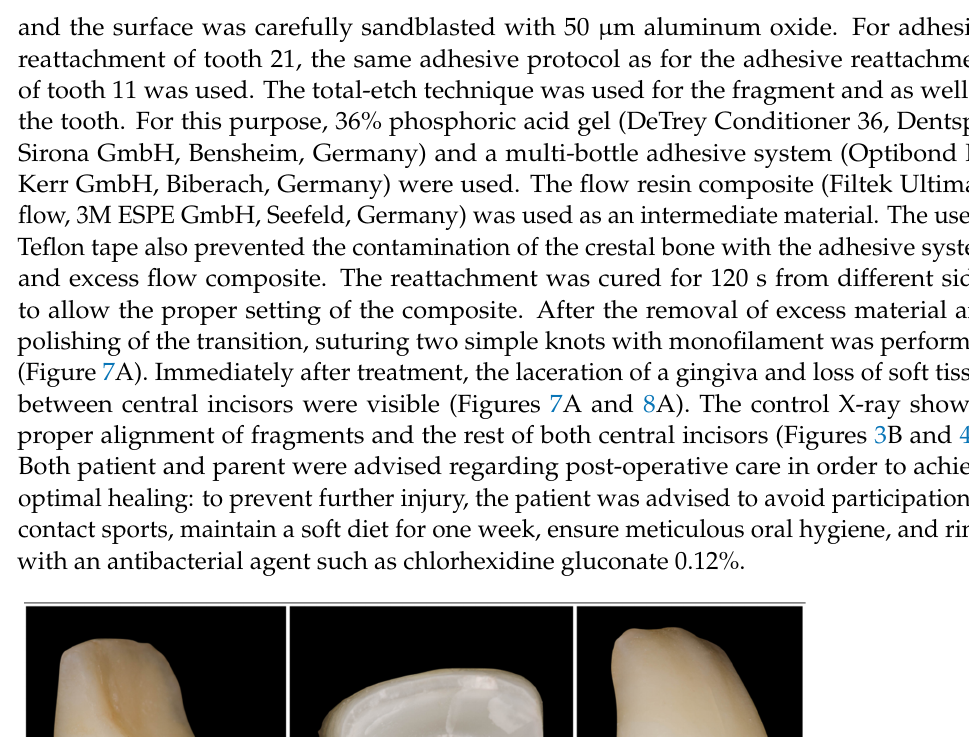
Figure 6. Fragment of tooth 21. ( A )—distal side of fragment with clearly visible location of fracture line apically to cementoenamel junction; ( B )—cervical side of fragment with enlarged pulp chamber; ( C )—mesial side of fragment. Children 2021 , 8 , x FOR PEER REVIEW